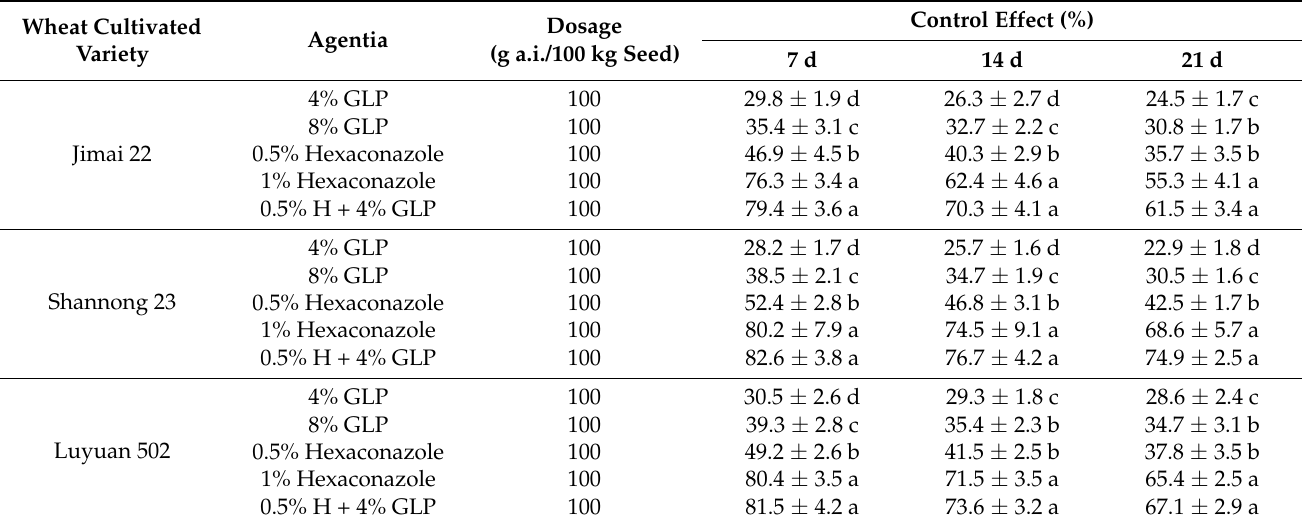
Table 10. Control effect of seed treatment on wheat root